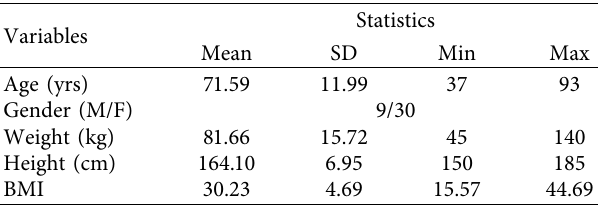
Table 1: Demographic characteristics of the total group of cases ( N � 39).